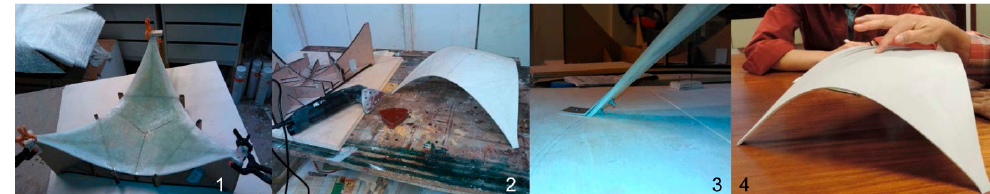
Figure 9. Building the model: ( 1 ) strengthening with fibreglass fabric; ( 2 ) surface regularization and pre-finishing with coating; ( 3 ) supports; and ( 4 ) final (robust) model. pre-finishing with coating; ( 3 ) supports; and ( 4 ) final (robust) model.